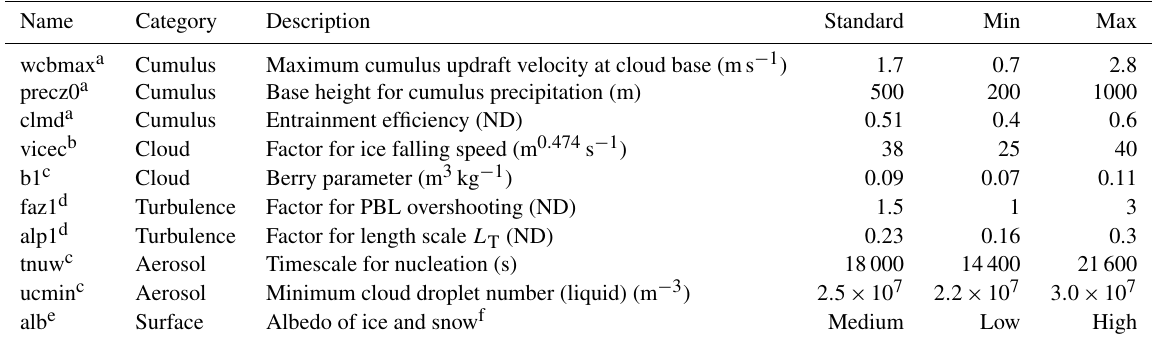
Table 1. List of physics parameters that were varied in the MIROC5 PPE.